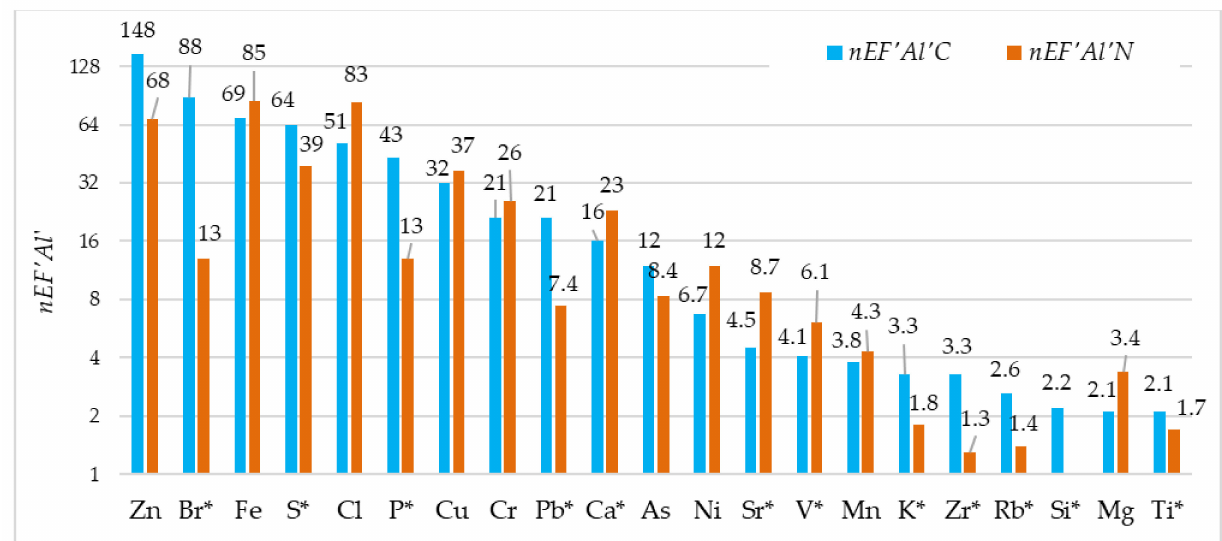
Figure 9. Mean values of nEF’Al’C and nEF’Al’N . The analytes are sorted by decreasing nEF‘Al’C values. *—analytes for which so-called contamination classes of alternative indices are